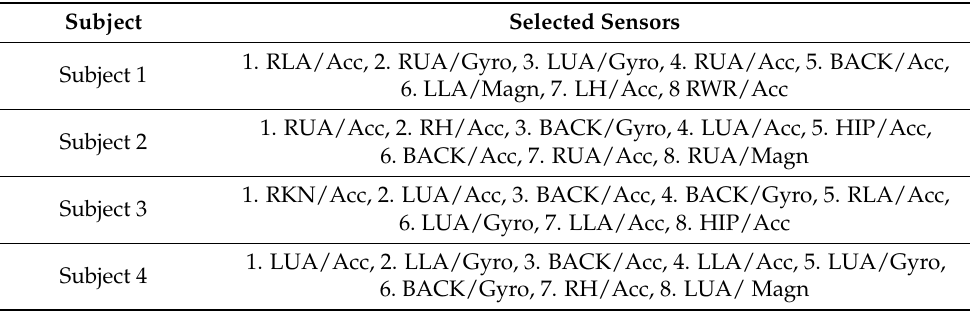
Table 2. Selection results of important sensors in OPPORTUNITY based on complementarity